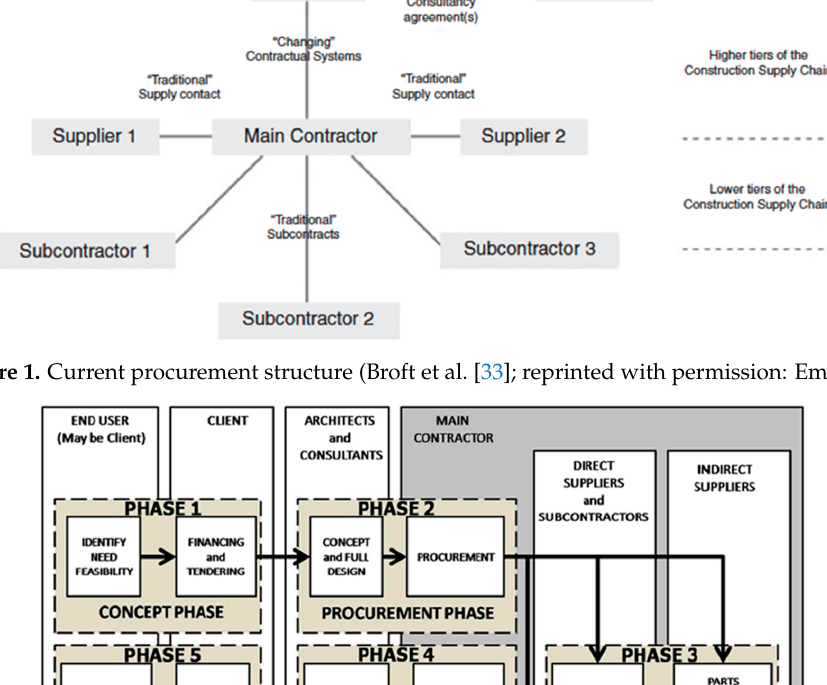
Figure 2. Phases in a typical construction project (Behera et al. [14]; reprinted with permission: Taylor and